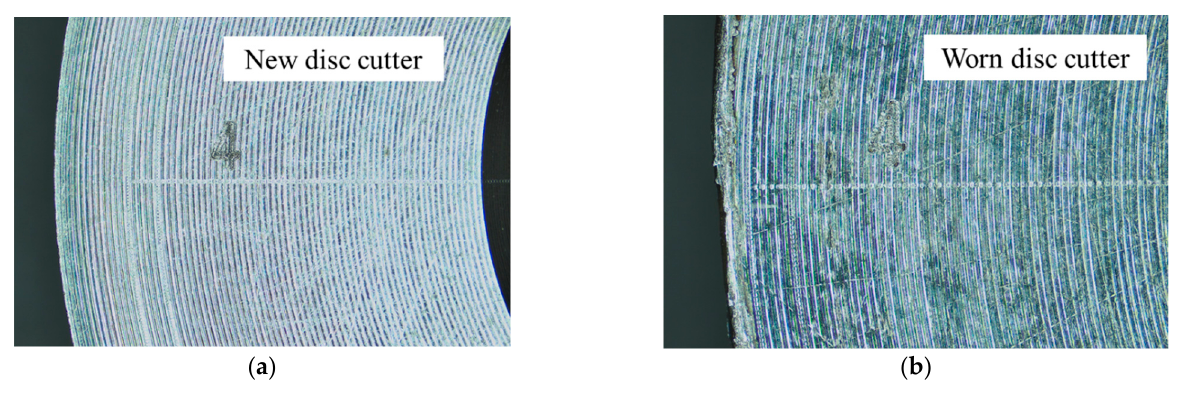
Figure 2. ( a ) A new disc cutter; ( b ) A worn disc cutter.